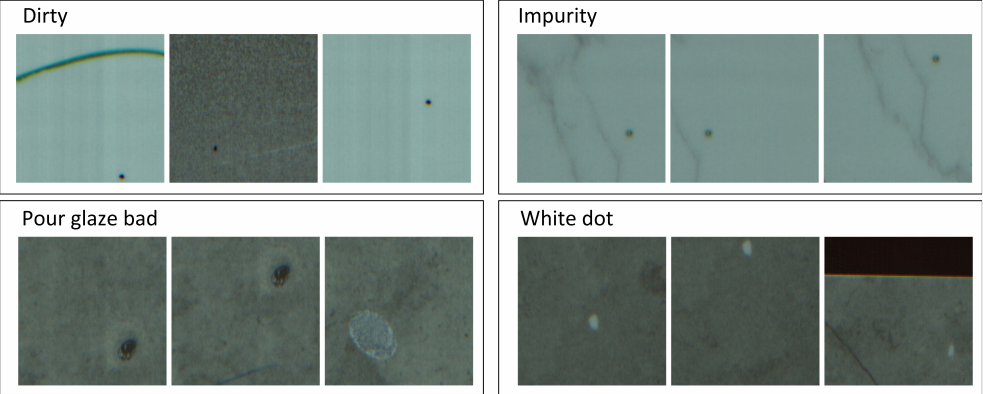
Figure 3. Different tile defect